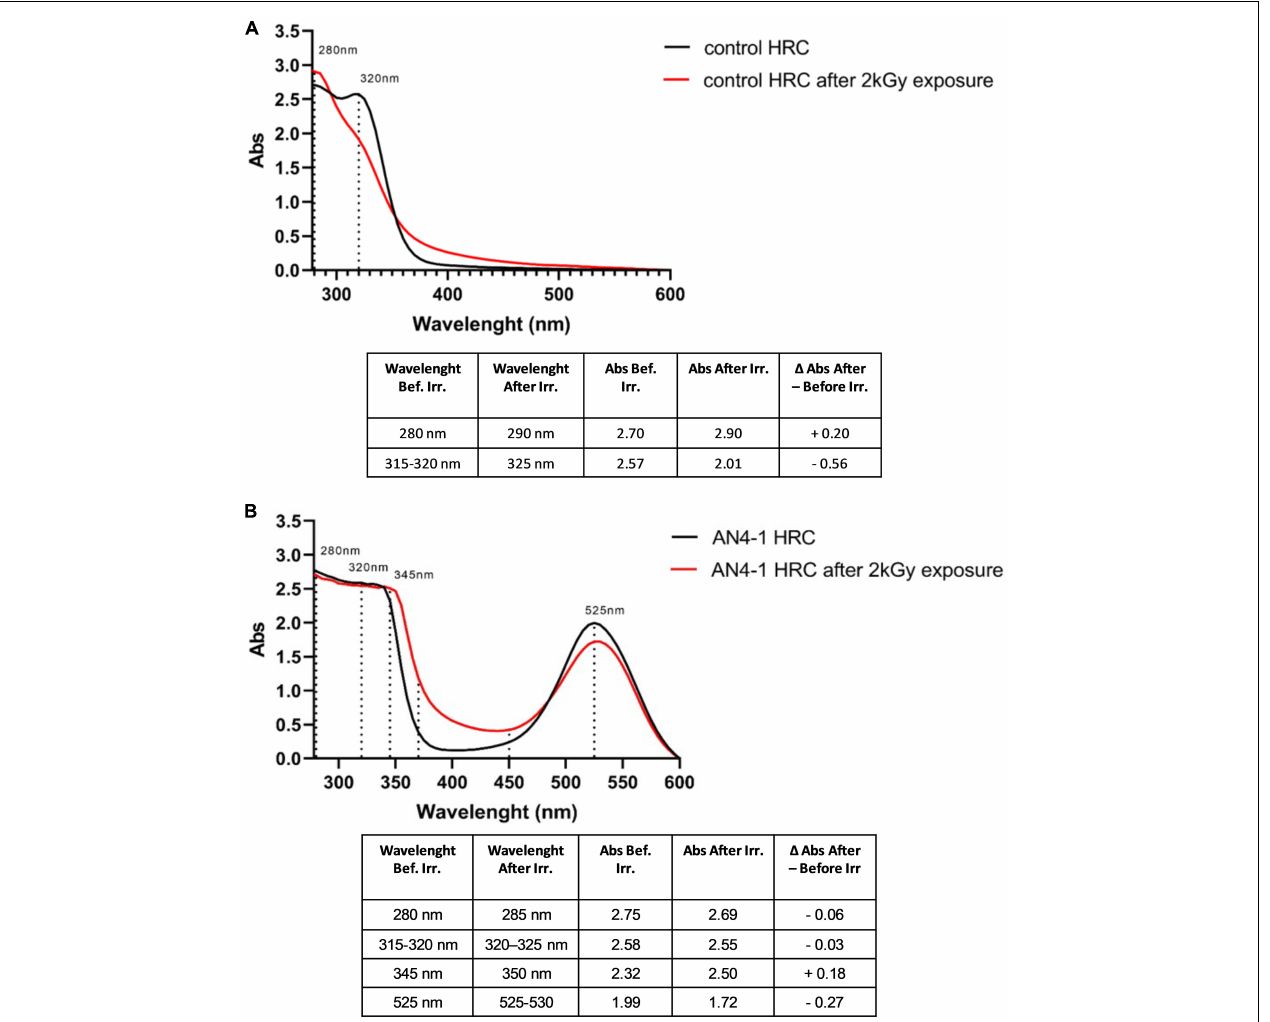
FIGURE 9 | UV-VIS spectra of MicroTom HRCs before and after 2 kGy absorbed dose. In control, peaks at 280 nm and 320 nm indicate the presence of flavonols, hydroxycinnamic acids, tannins, and flavanols (A) . In AN4-1, the additional peak at 345 nm completes the flavonols group profile compared to control, while the peak at 525 nm represents anthocyanins. The curve in the region between 400 and 450 nm refers to possible glycosylation, precipitation, complexation of anthocyanins (B)